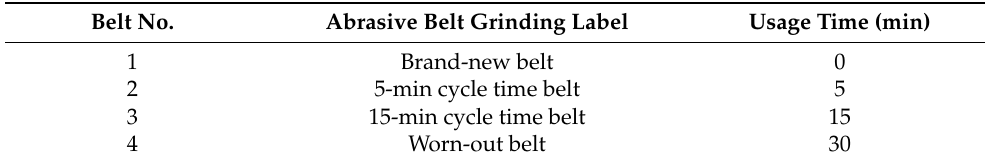
Table 2. Four states of abrasive belt under monitoring. Belt No.